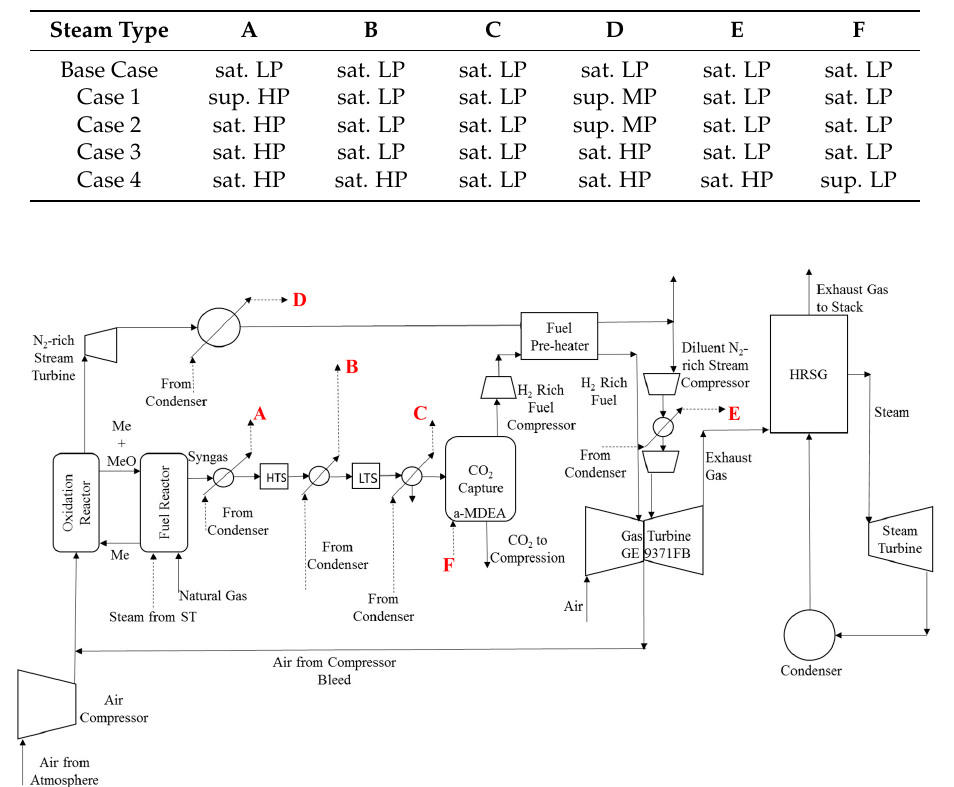
Figure 4. Schematic of the CLR-CC process for different heat integration options.